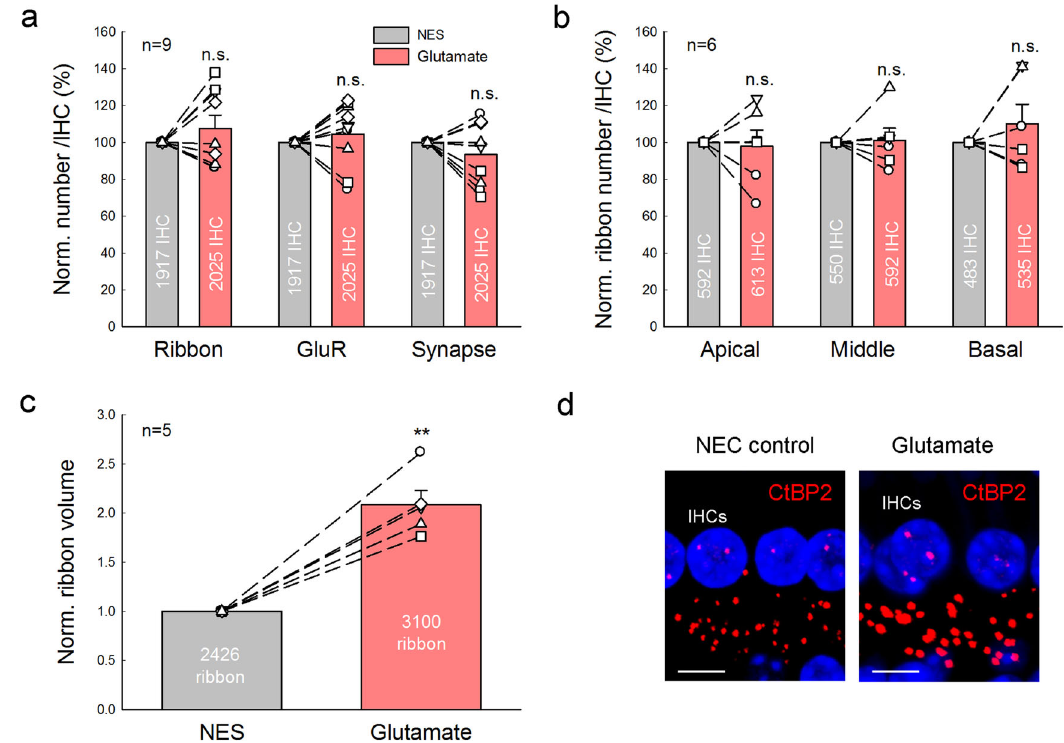
Fig. 6 Glutamate causes ribbon swelling but not synapse degeneration. One cochlea was incubated in NES with 0.2 mM glutamate for 2 h and another cochlea of the same mouse was simultaneously incubated with NES as control. Dashed lines connected two same symbols represent data collected from two cochleas of the same animal. N is the number of mice. a Glutamate has no signi fi cant effect on IHC ribbon, GluR, and synapse degeneration. The numbers of ribbon, GluR, and synapse per IHC were pooled from all cochlear turns and averaged and normalized to those in the control cochlea of the same mouse. P = 0.30 – 0.42, paired t -test, two-tail. b There are no signi fi cant ribbon degenerations in the different cochlear turns for glutamate challenge. The ribbon numbers per IHC in the different cochlear turns were normalized to those in the control cochlea of the same mouse. P = 0.45 – 0.91, paired t - test, two-tail. c , d Glutamate-induced IHC ribbon swelling. d Immuno fl uorescence staining for CtBP2 at the middle cochlear turn area in the glutamate- treated group and control group. IHC ribbons in the glutamate treated cochlea appear enlarged. Scale bar: 10 µ m. ** P < 0.01, paired t -test,